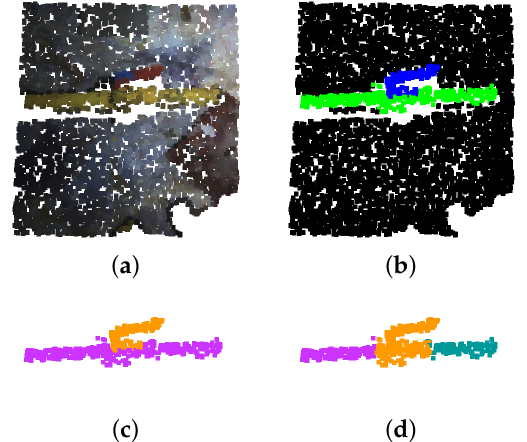
Figure 6. Point cloud clustering and valve reclassification. ( a ) Original point cloud. ( b ) Deep neural network segmentation. ( c ) Instance clustering. ( d ) Valve reclassification. Instances are represented following the purple, orange, teal and garnet colour